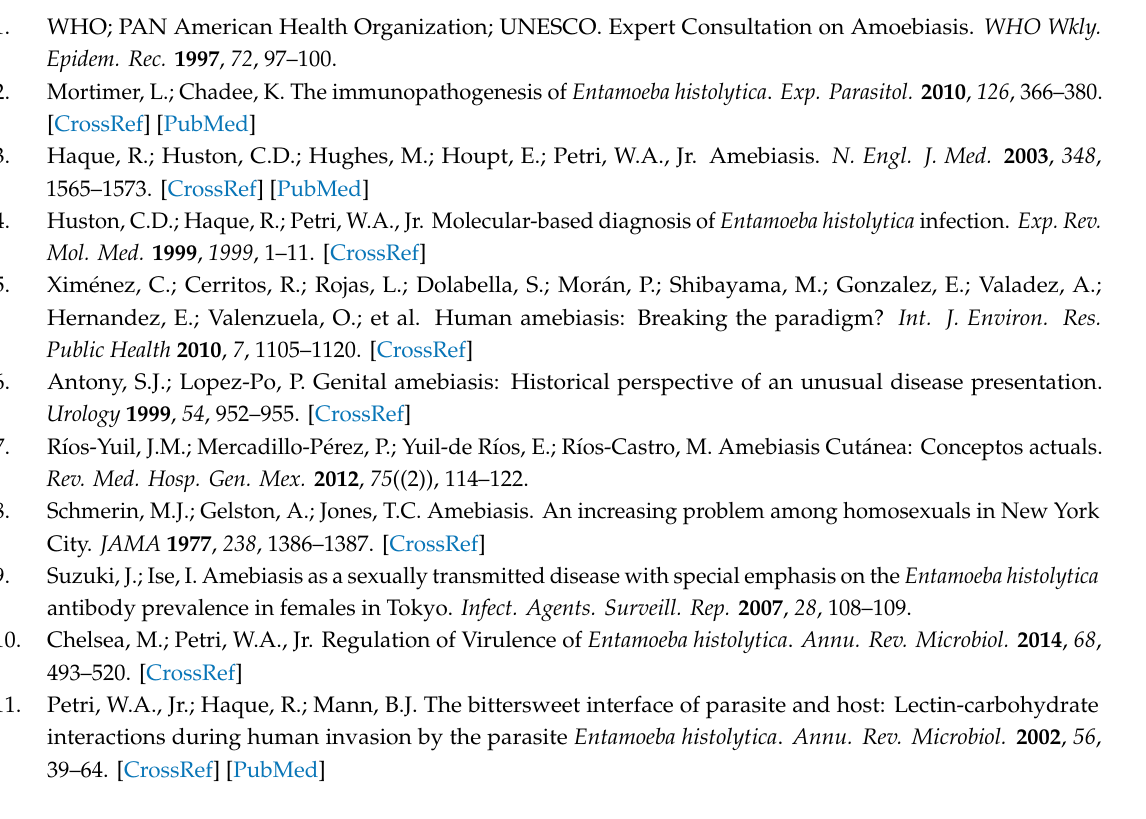
Supplementary Table S1: Individual ELISA test results. Supplementary Table S2: Results of di ff erential expression of E. histolytica genes in two forms of extraintestinal infection, (ALA and GA) by